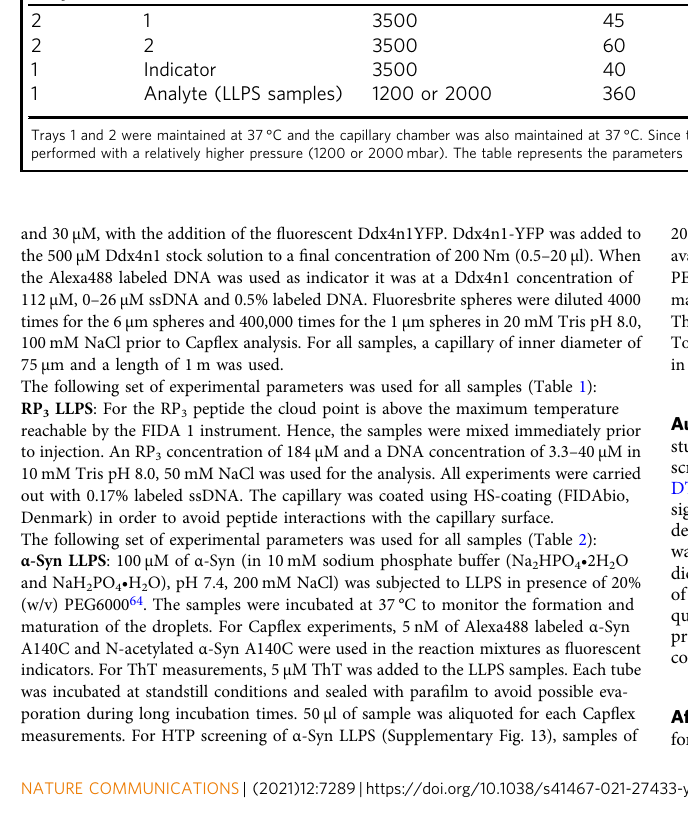
The following set of experimental parameters was used for all samples (Table 2): α -Syn LLPS : 100 μ M of α -Syn (in 10mM sodium phosphate buffer (Na and NaH 2 PO 4 (cid:129) H 2 O), pH 7.4, 200mM NaCl) was subjected to LLPS in presence of 20% (w/v) PEG6000 64 . The samples were incubated at 37°C to monitor the formation and maturation of the droplets. For Cap fl ex experiments, 5nM of Alexa488 labeled α -Syn A140C and N-acetylated α -Syn A140C were used in the reaction mixtures as fl uorescent indicators. For ThT measurements, 5 μ M ThT was added to the LLPS samples. Each tube was incubated at standstill conditions and sealed with para fi lm to avoid possible eva- poration during long incubation times. 50 μ l of sample was aliquoted for each Cap fl ex measurements. For HTP screening of α -Syn LLPS (Supplementary Fig. 13), samples of NATURE COMMUNICATIONS| (2021) 12:7289